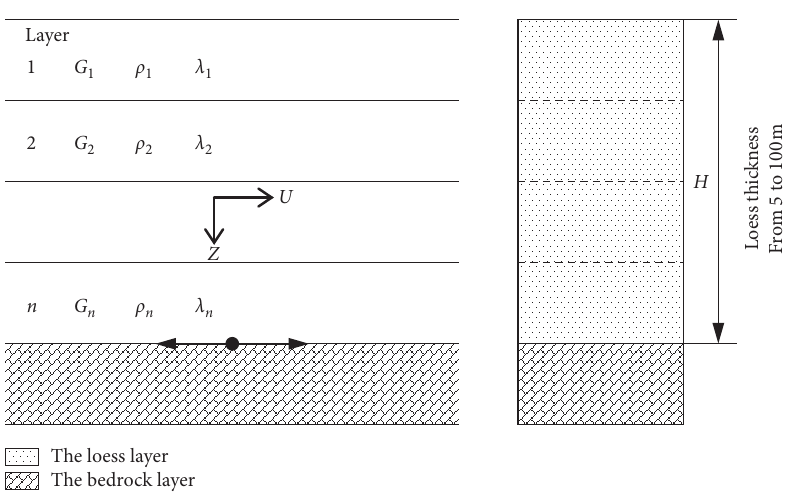
Figure 5: One-dimensional idealization calculation